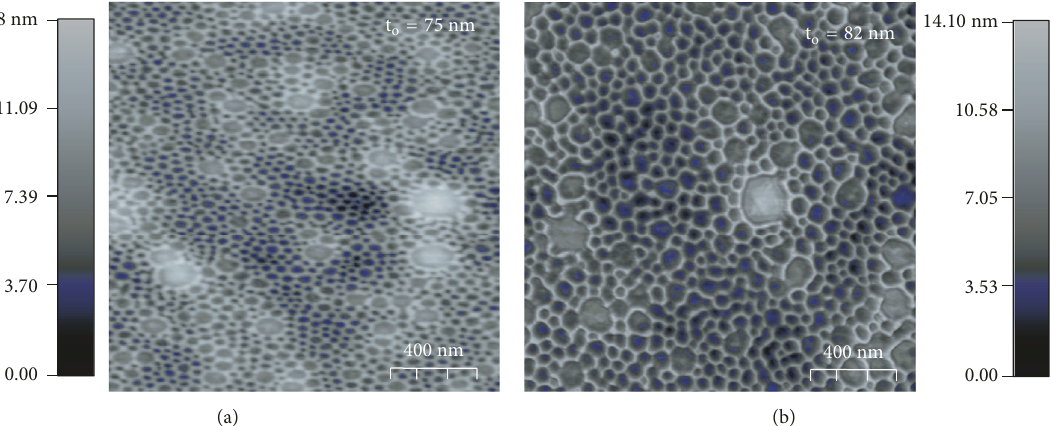
Figure 4: AFM height images of highly sulfonated samples without any annealing treatment. (a) M2 52/s48 DS of 90% and (b) M2 56/s44 DS of 87%.